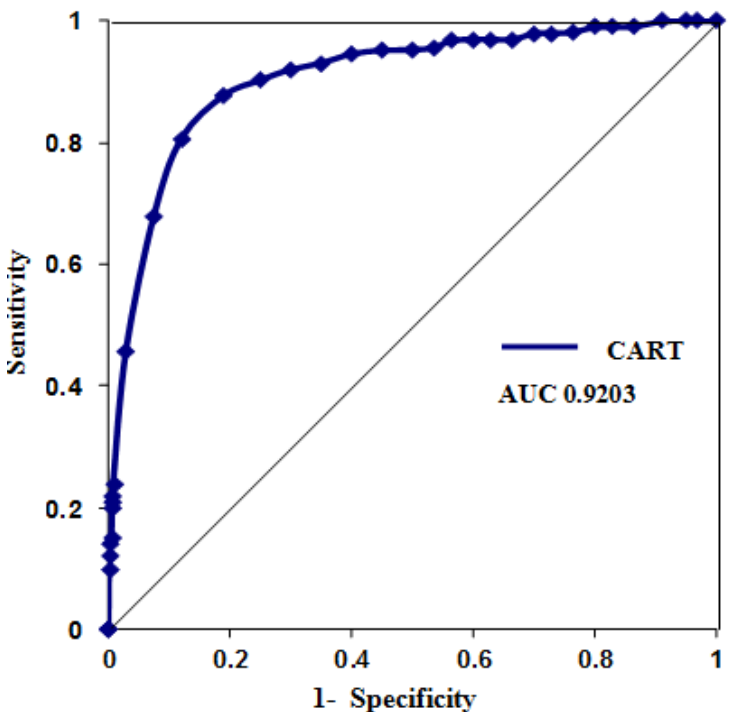
Figure 11. ROC curve for groundwater potentiality map produced the CART and area under curve (AUC).